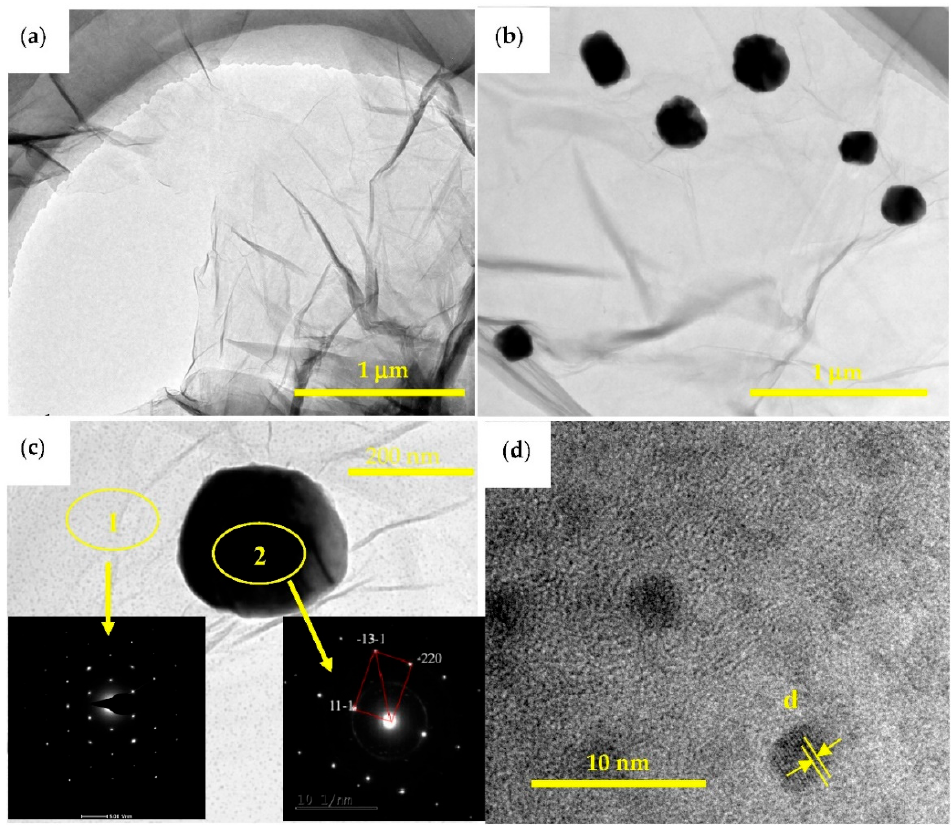
Figure 9. ( a , b ) Backscattered electron image and ( c , d ) energy dispersive X-ray spectrometer C element mapping and Ni element mapping of Ni@graphene.